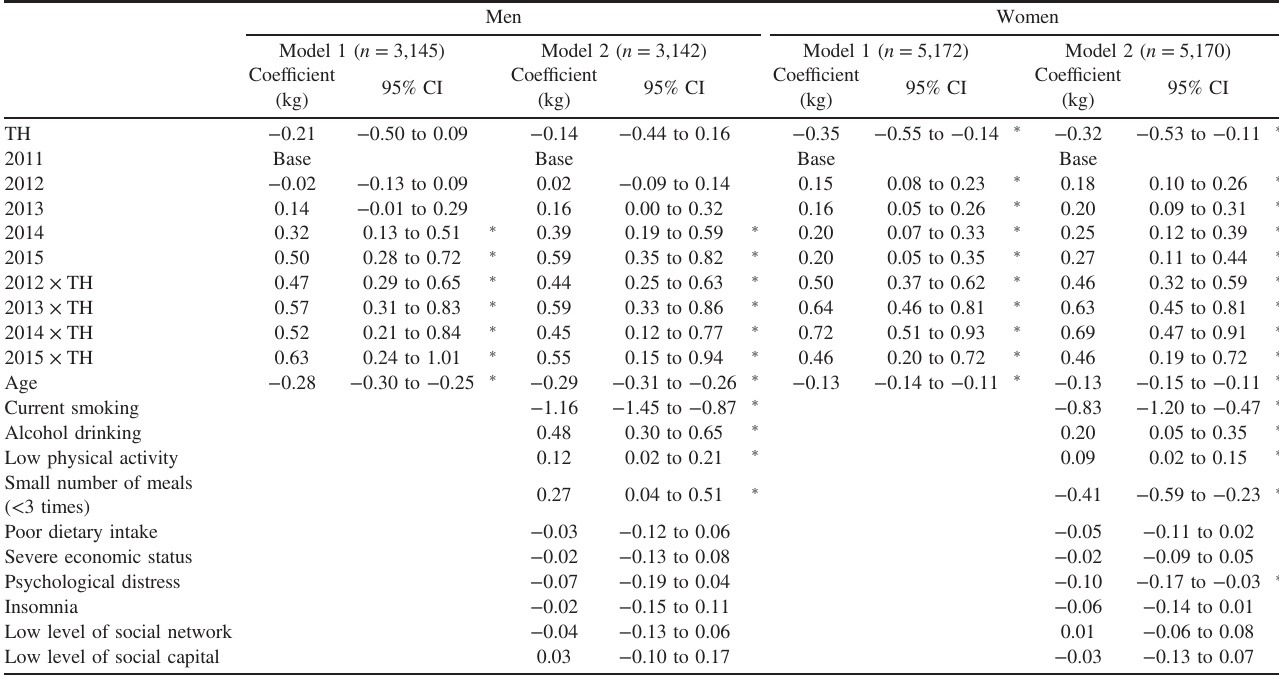
Table 2. Coe ffi cient of mixed e ff ects using linear mixed e ff ects models